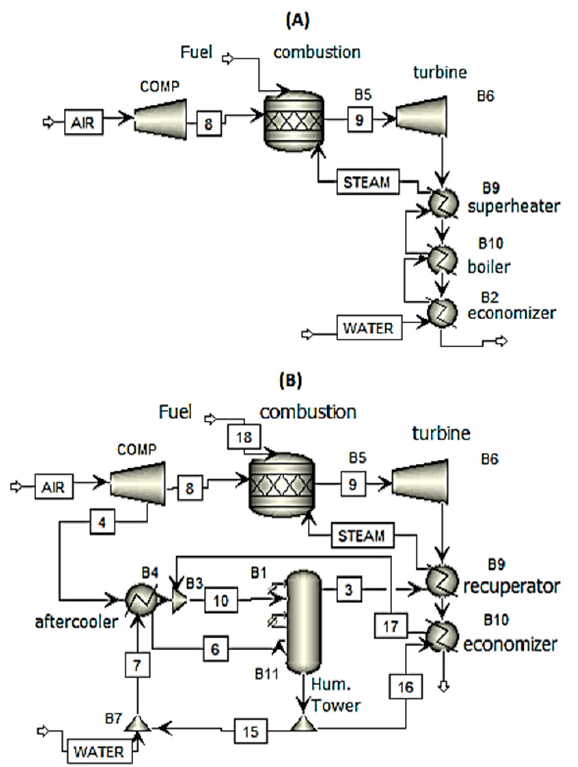
Figure 2. Schematic steam-injection-based gas turbine ( A ) and one possible evaporation-based gas turbine cycle ( B ).